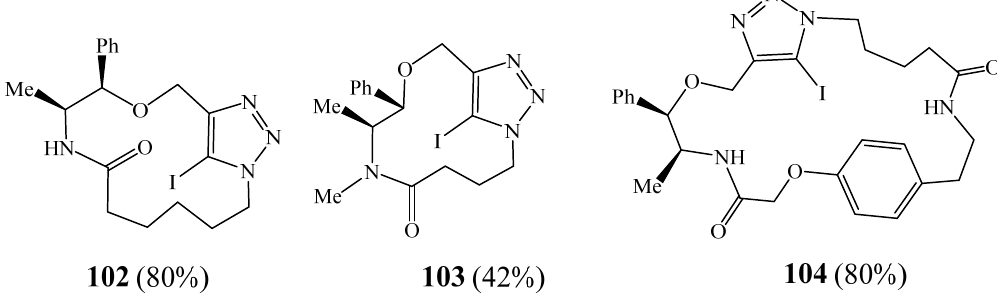
Figure 26. Structures of tetra-triazolic macrocycles 102 − 104. (Reprinted with permission from ref. [46]. Copyright 2011 American Chemical Societ).